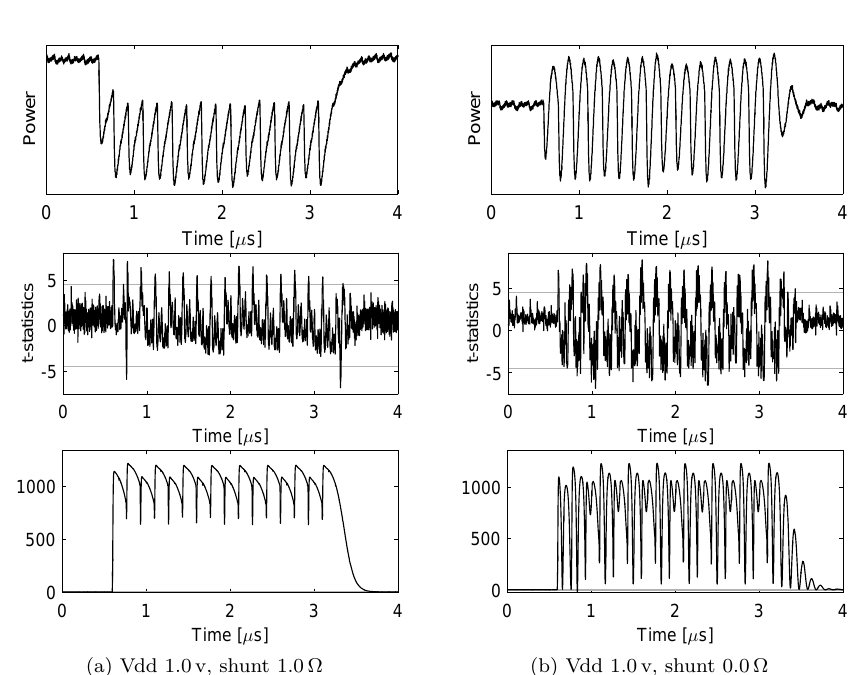
Figure 4: Case study 1: iterated_MC 1 , 4 , 3 MC modules, clock 6 MHz, room temperature, (top) sample power trace, (middle) 1st-order and (bottom) 2nd-order t -test results using 100 million